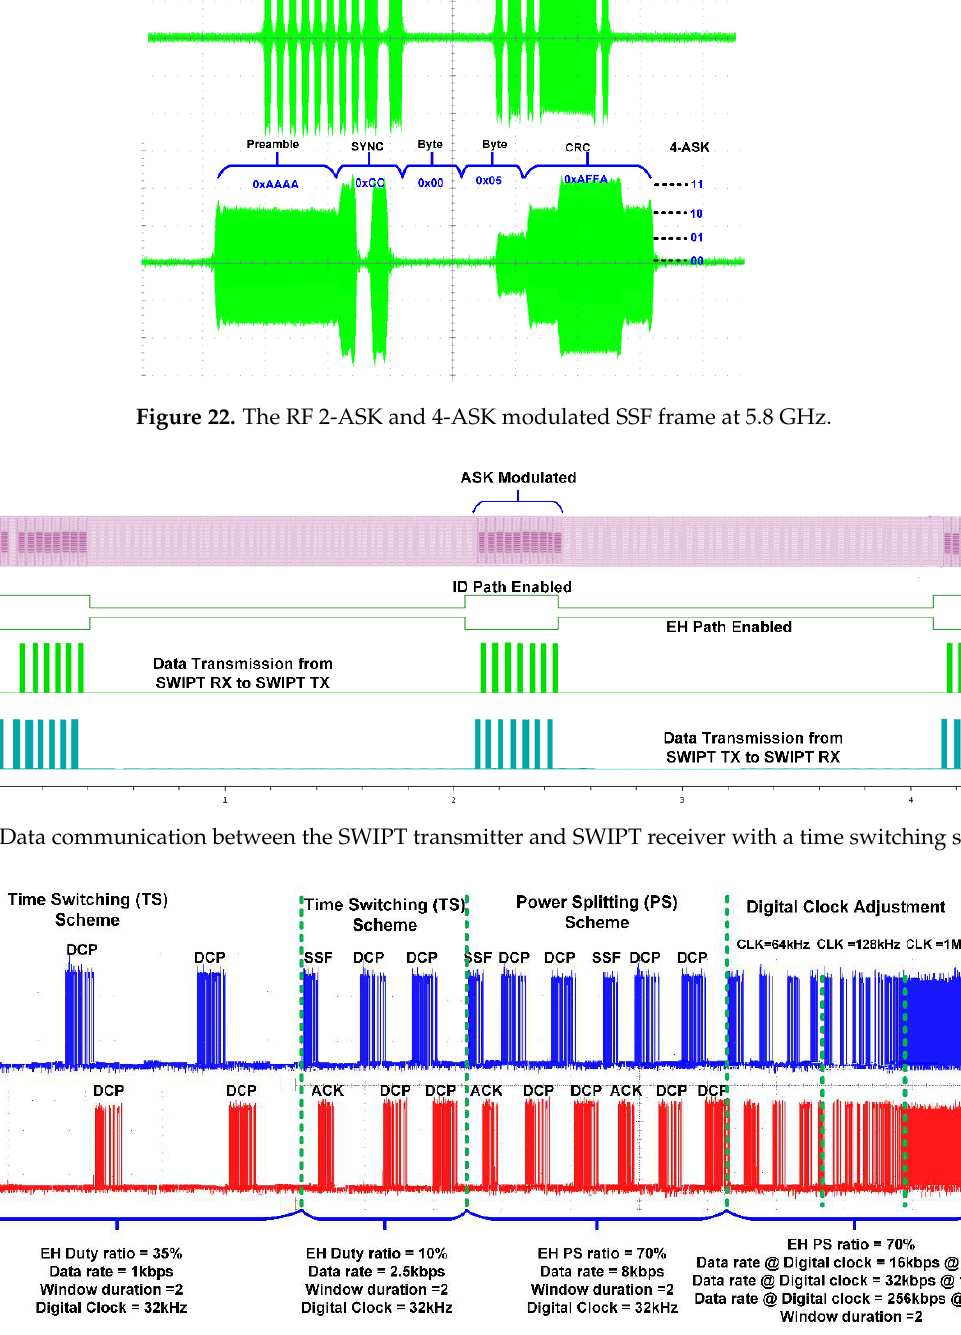
Figure 24. SWIPT system mode switching and effects on data rates. Table 1. Performance comparison with the PCB-based SWIPT.